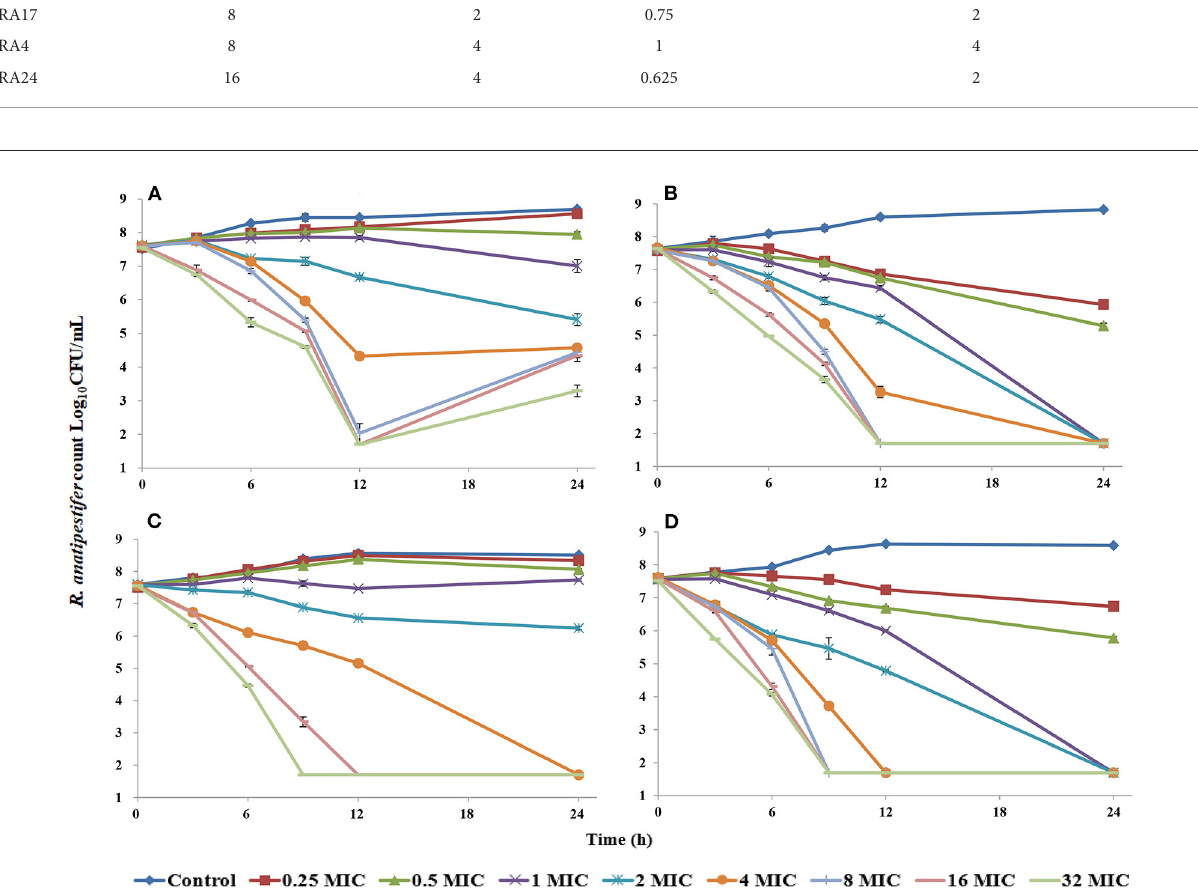
FIGURE1 Time–kill studies of florfenicol alone and in combination with doxycycline against Riemerella anatipestifer at constant concentrations [FF alone: (A) , CVCC3952; (B) , CVCC3857; FF in combination with DOX: (C) , CVCC3952; (D) , CVCC3857].